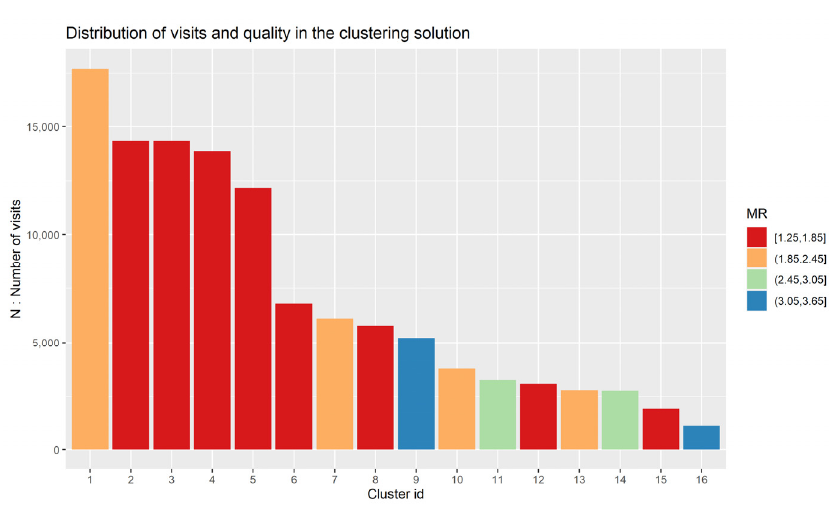
Figure 2. Histogram of the distribution of visits and quality in the 16-cluster solution. The MR indicator is illustrated using a 4-color gradient with red color signaling a smaller value.